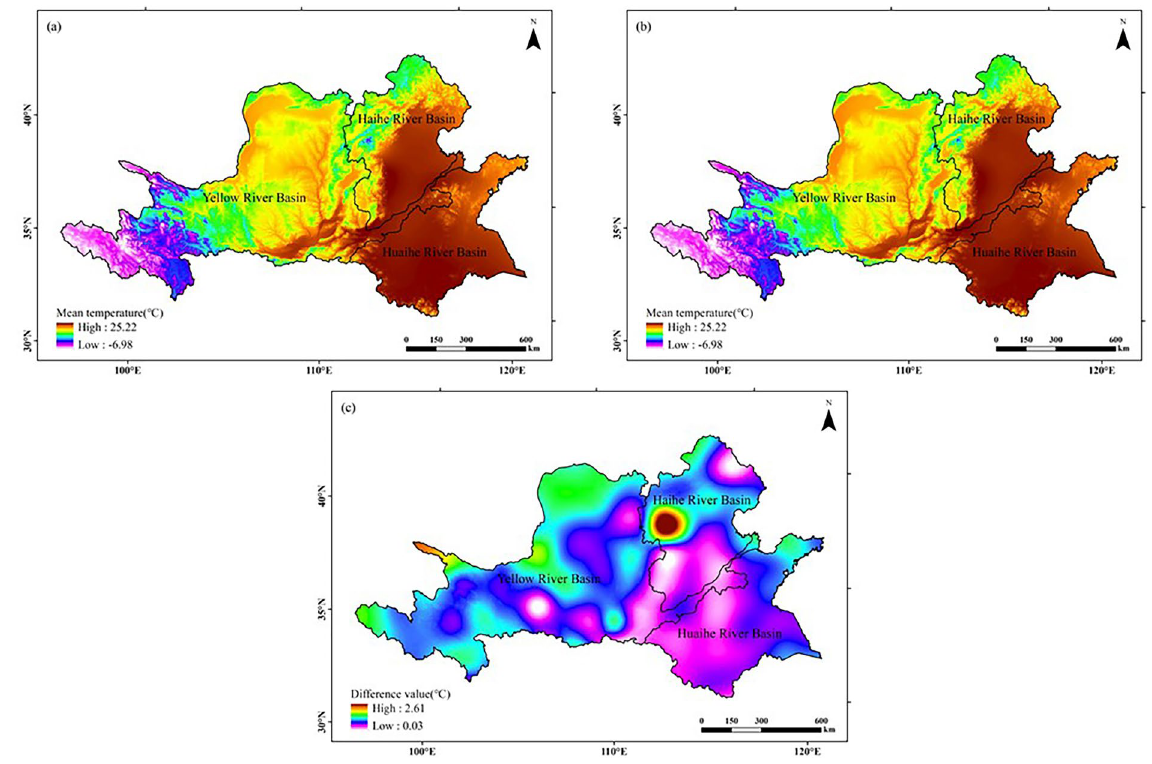
Figure 2. Comparison of average temperature distribution in peanut growing season in the Huang-Huai-Hai region in two climatic years: ( a ) 1960–1989; ( b ) 1990–2019; ( c ) ( b )–( a ). The figure was made in the ArcGIS 10.2 platform (https:// www. esri. com/ en- us/